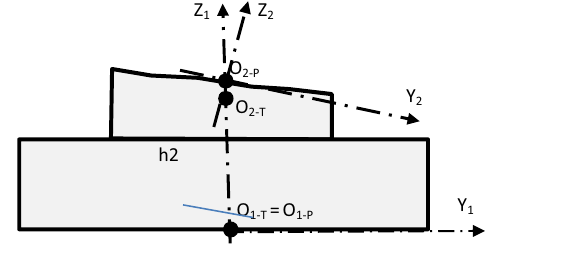
Fig. 4. Presentation of individual part.